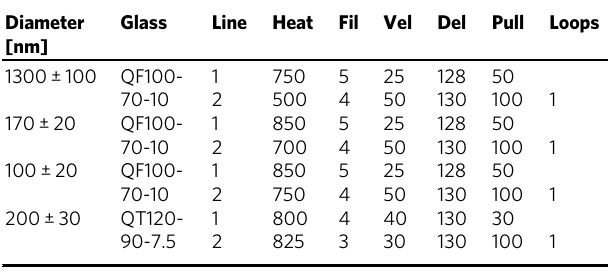
Pulling parameters for single (QF100) and two-channel (QT120) quartz nozzles. Heat, fi lament ( fi l),velocity(vel),delay(del)andpullrefertothe fi